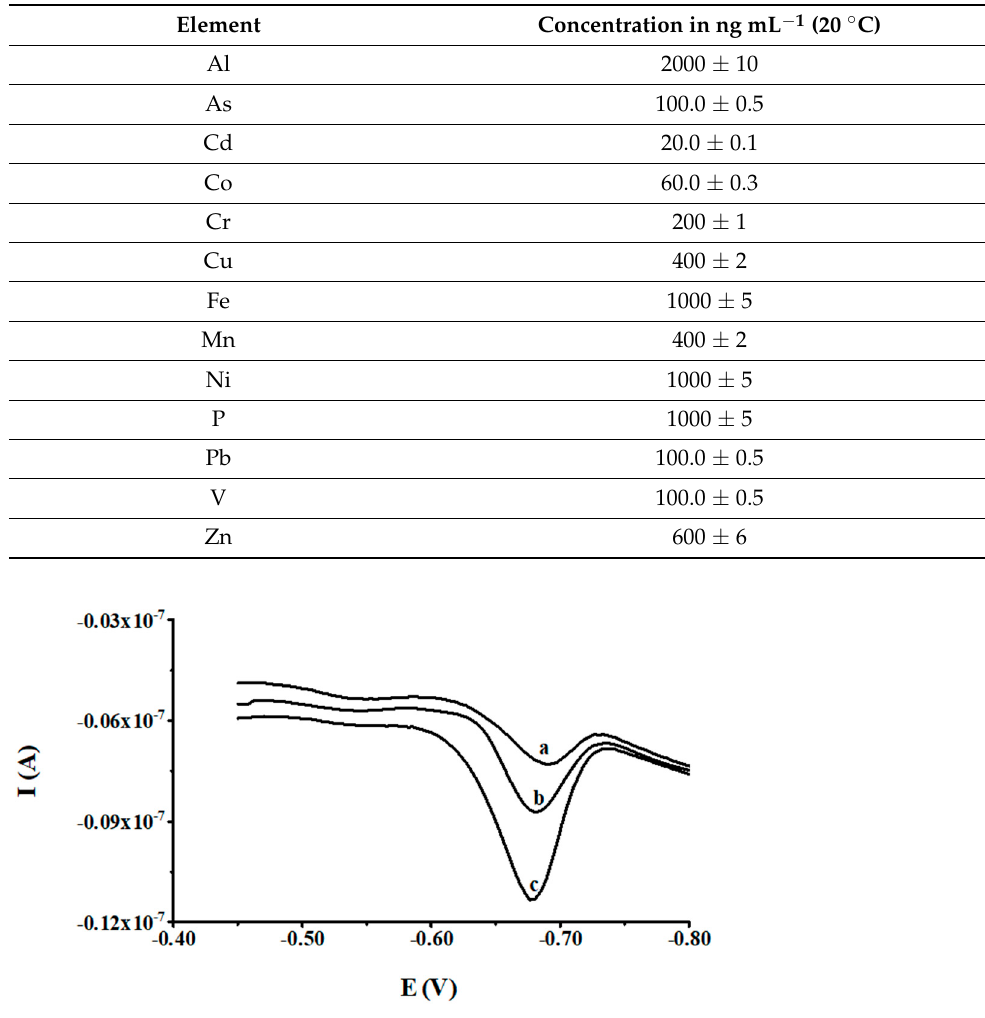
Table 2. Concentrations of the elements in the certified reference material SPS-WW1 waste water.